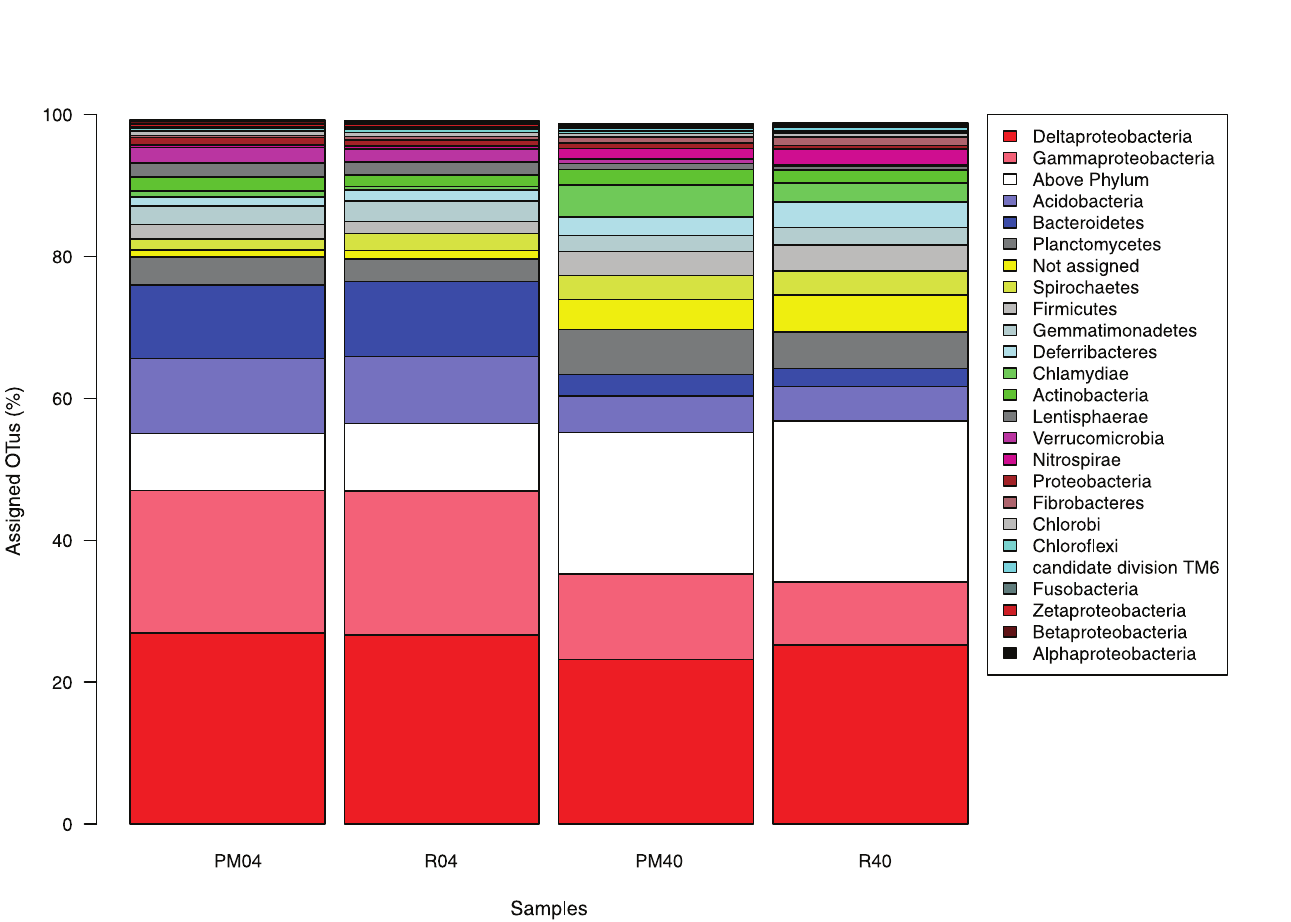
Figure 6. Phylum level abundances of representative OTU sequences. The Lowest common ancestor algorithm was used to classify OTU sequences with blastN against the SILVA V108 SSURef database. The phylum Proteobacteria was split to accommodate for the different abundances within the various sub clades. OTUs that did not classify to the proteobacterial subclades were assigned to the taxon Proteobacteria. The group ‘‘Not assigned’’ consists of sequences with significant blast hits but could not be classified using the set LCA parameters. The group ‘‘Above phylum’’ contains OTU sequences assigned to either the kingdom Bacteria or to cellular organisms. Note that only the top 25 taxa are indicated for clarity. doi:10.1371/journal.pone.0085990.g006 PLOS ONE |